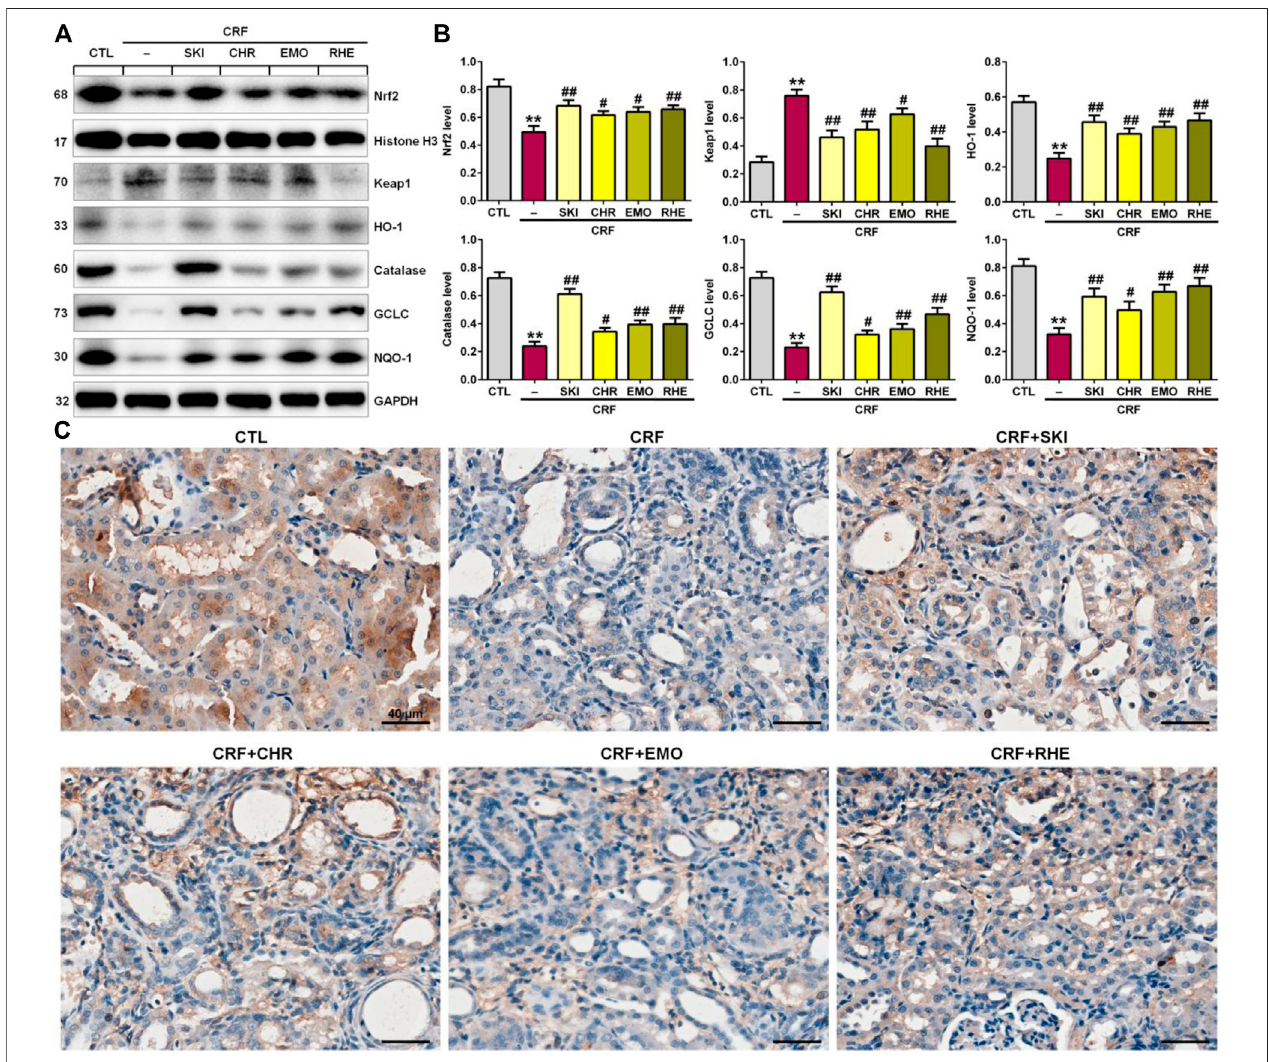
FIGURE 5 | SKI and three anthraquinones including chrysophanol, emodin, and rhein activated the anti-in fl ammatory and anti-oxidative Keap1/Nrf2 signaling pathwayintheadenine-inducedCRFrats. (A) ProteinexpressionsofnucleartranslocationofNrf2anditsrepressor,Keap1,anditsdownstreamgeneproductsincluding HO-1, catalase, GCLC, and NQO-1 of the kidney tissues in the different groups. (B) Quantitative analysis of anti-in fl ammatory and anti-oxidative protein expressions of thekidneytissuesinthedifferentgroups.** p < 0.01comparedwiththeCTLgroup; # p < 0.05, ## p < 0.01comparedwiththeCRFgroup. (C) Immunohistochemical analysis with anti – HO-1 of the kidney tissues in the different groups. Scale bar, 40 μ